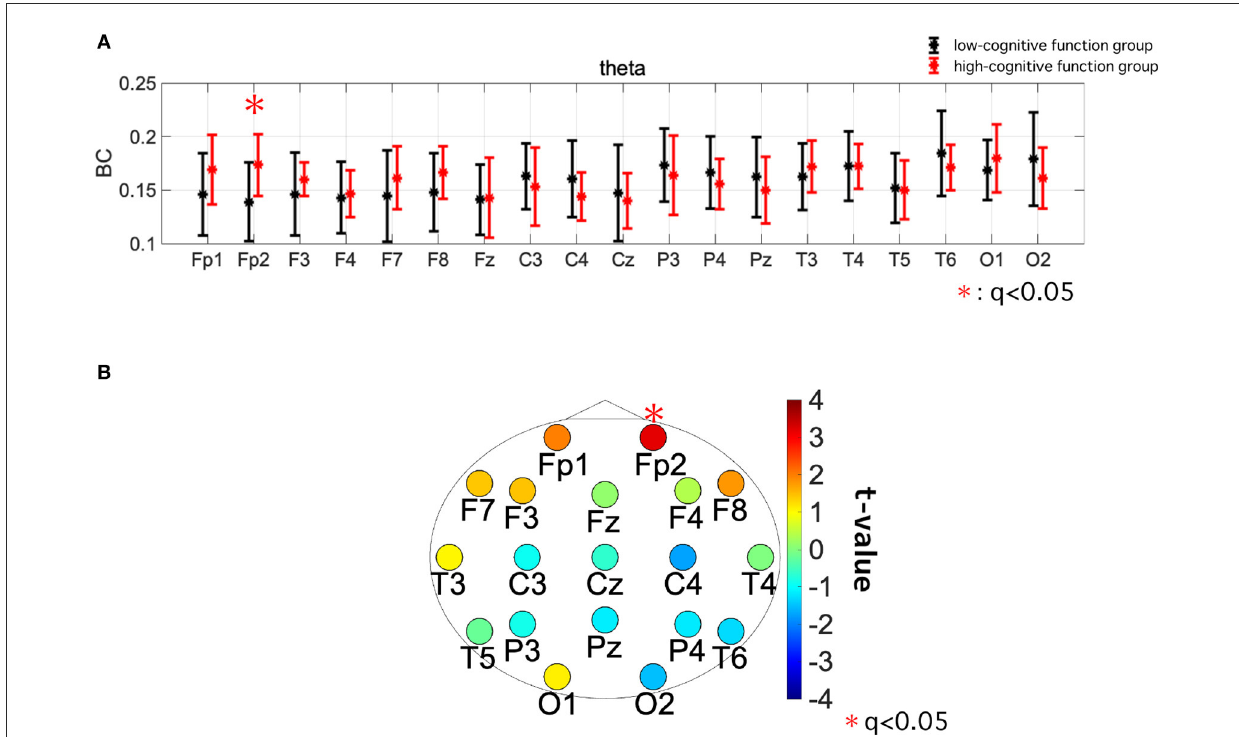
FIGURE3 (A) Mean value and standard deviation of betweenness centrality (BC) within each group (high- and low-cognitive function groups) in the theta band. The dots and error bars represent the mean and standard deviation, respectively. (B) The topography of t -values of the value of BC in the theta band. Warm colors indicate that the high-cognitive function group has a greater value than the low-cognitive function group. The significantly greater BC value at Fp2 for high-cognitive function than low-cognitive function [ t = 3.23 ( p = 0.0026)], which satisfied with criteria of FDR ( q < 0.05), was